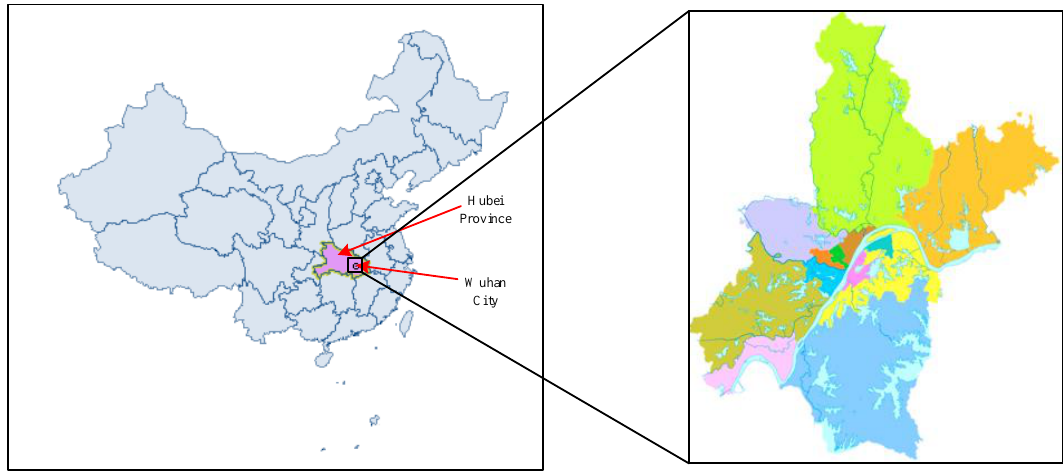
Figure 1. The location of Wuhan in China.